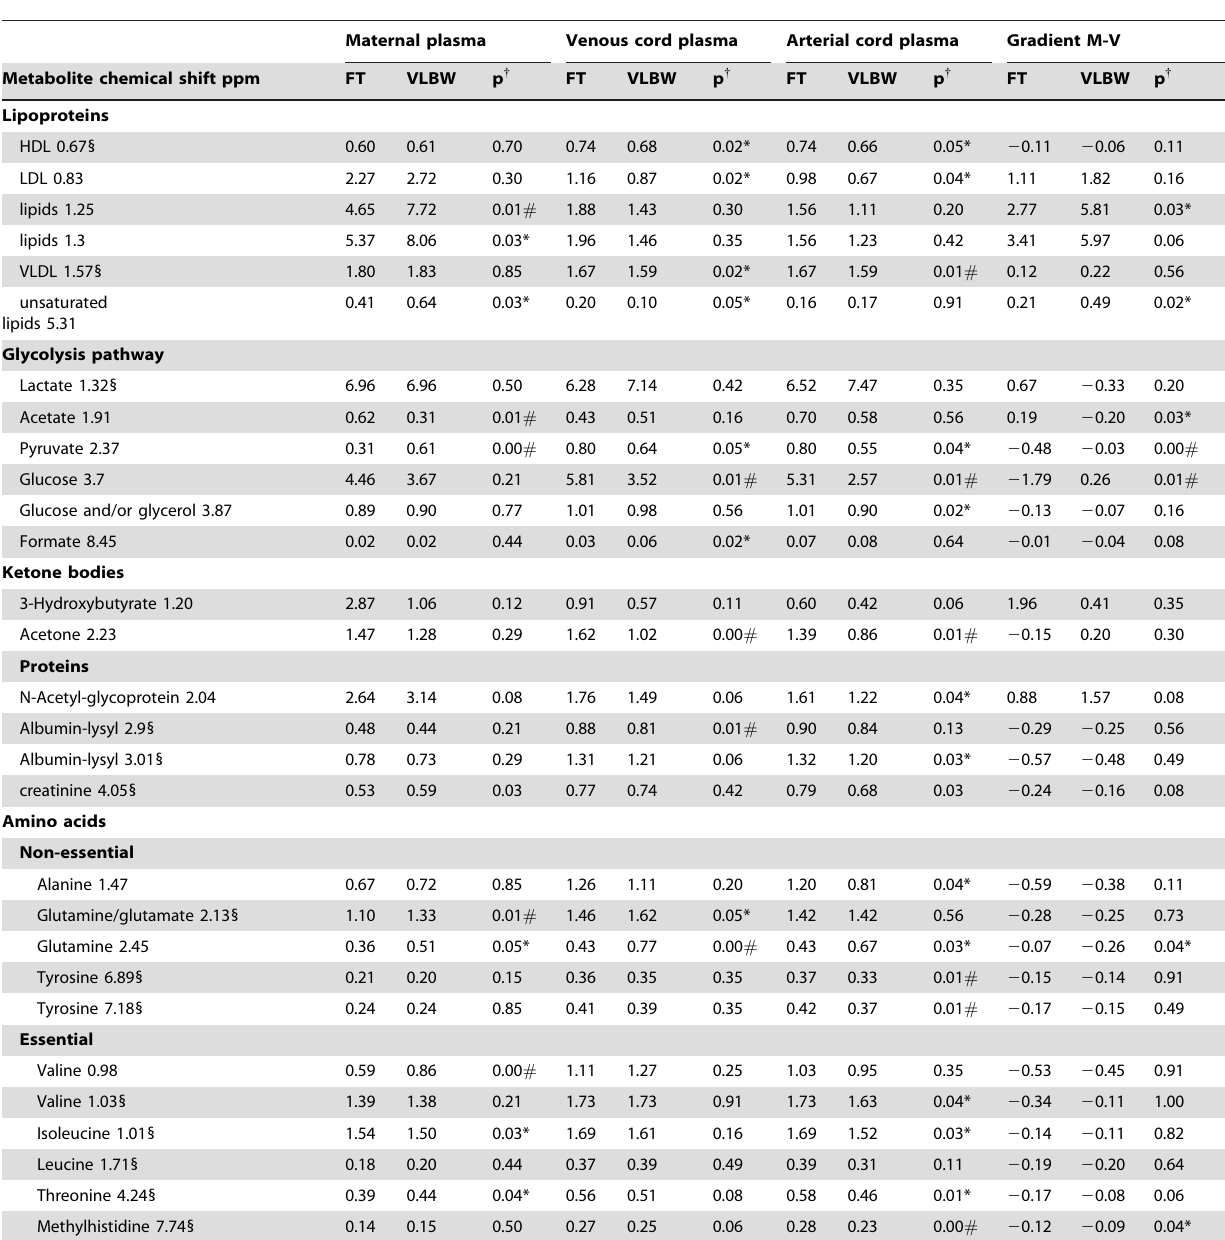
Table 2. Maternal and cord blood plasma metabolite differences between full-term and VLBW subjects.